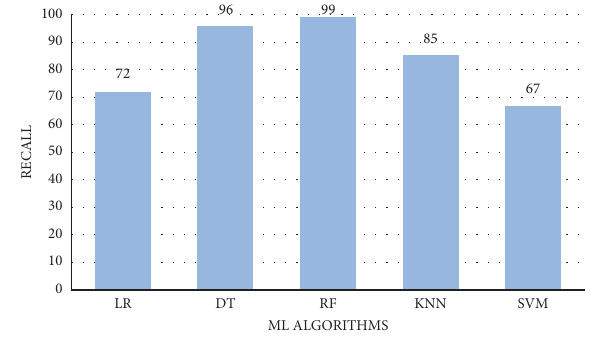
Figure 10: Comparison of